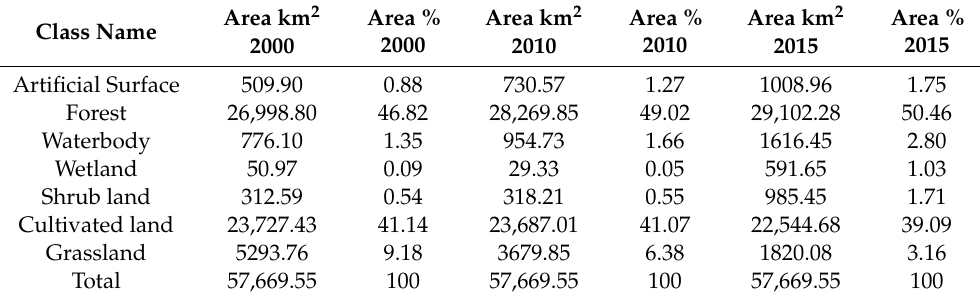
Table 3. Land use change in the TGRC from 2000 to